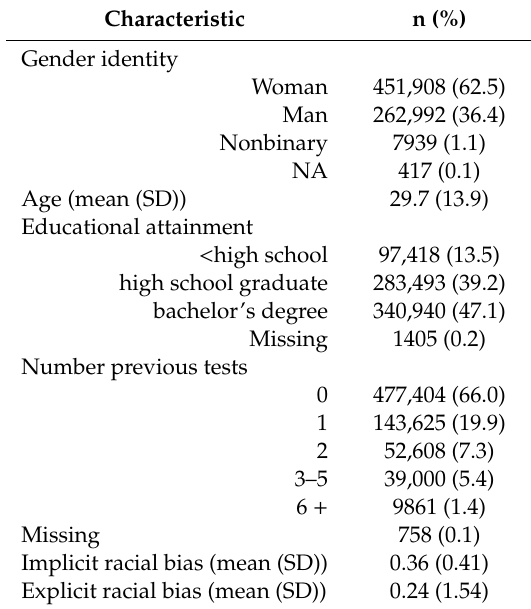
Table A1. Characteristics of IAT test-takers aggregated to create county average IAT scores, 2017–2019 (n =